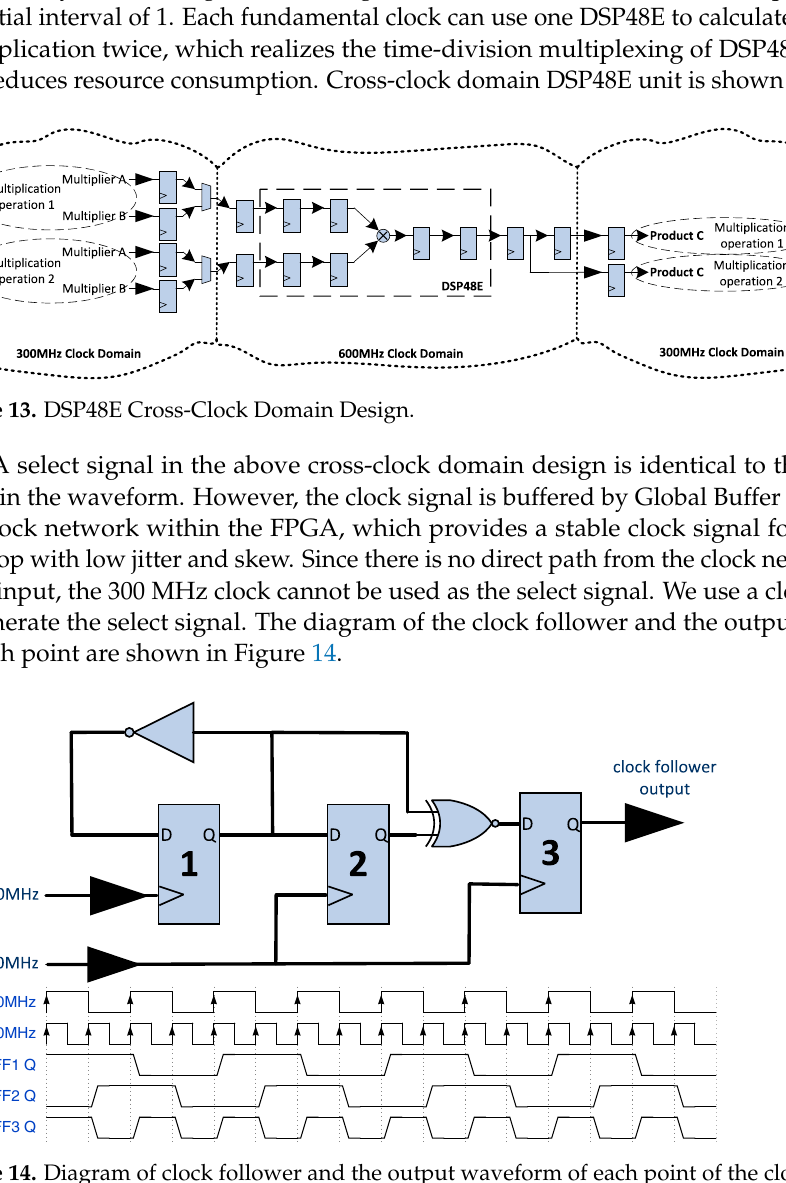
Figure 14. Diagram of clock follower and the output waveform of each point of the clock